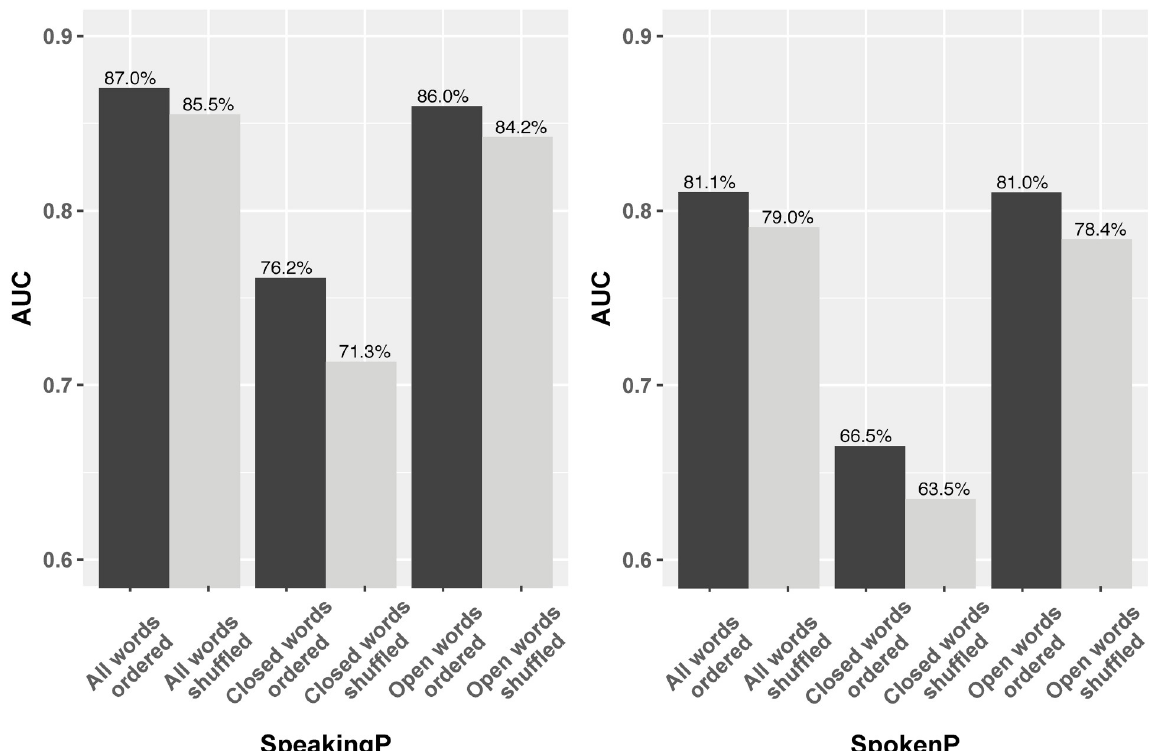
Fig 4. Barplot of AUC comparison for word categories and word ordering in the full dataset.